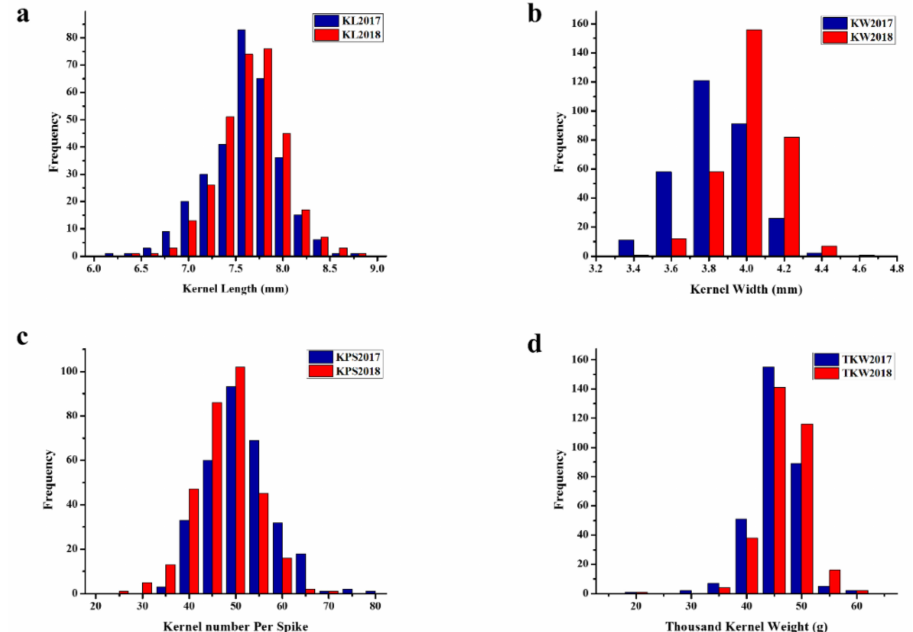
Figure 1. Frequency distribution of the kernel traits: ( a ) the kernel length, ( b ) kernel width, ( c ) kernels per spike, and ( d ) the thousand kernel weight in 2017 and